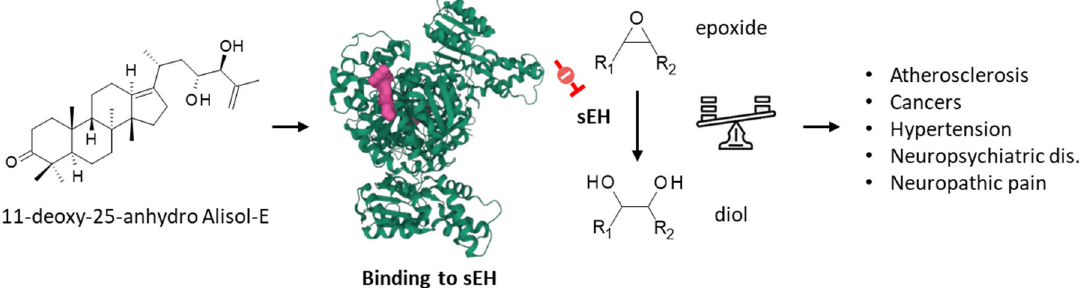
Figure 5. Binding of 11-deoxy-25-anhydro alisol-E to soluble epoxide hydrolase (sEH), the enzyme which converts epoxide molecules into diol molecules, as represented. The modulation of the epox- ide/diol ratio is a mechanism by which the compound exerts activities against multiple pathologies, as indicated.